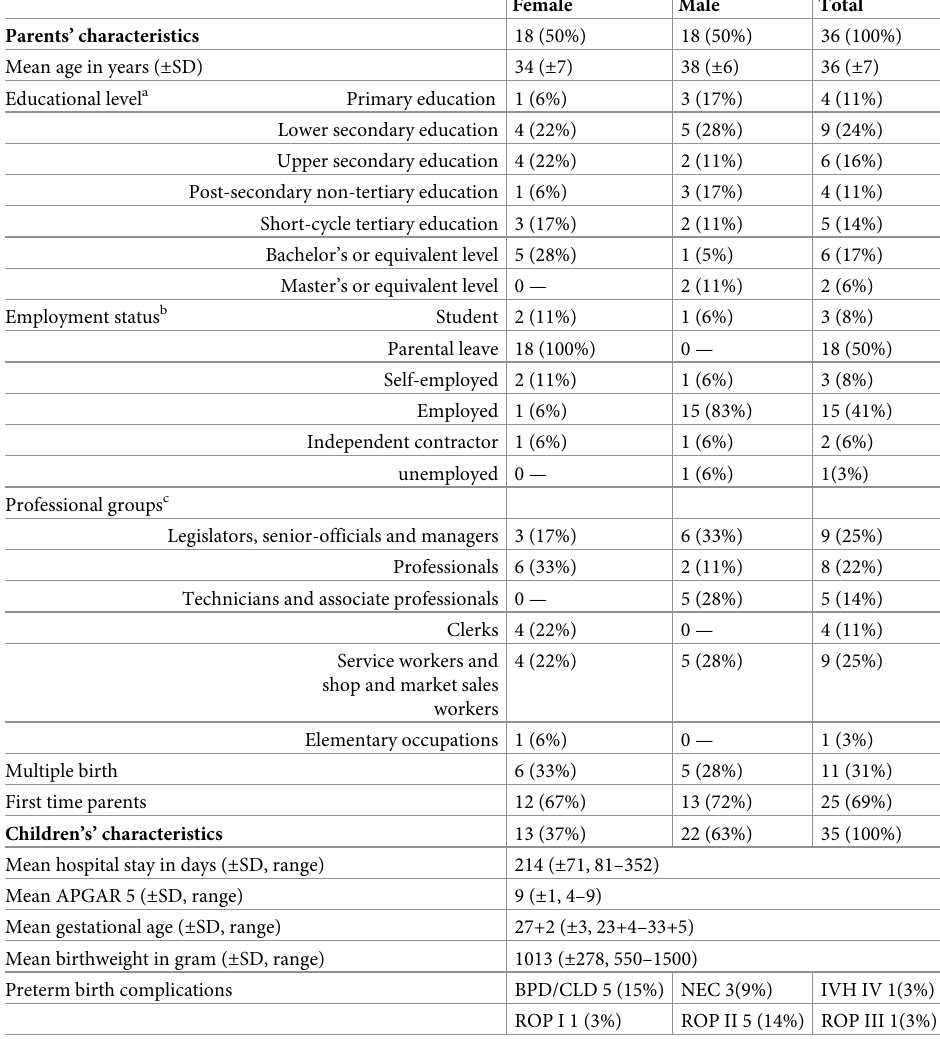
Female Male Total